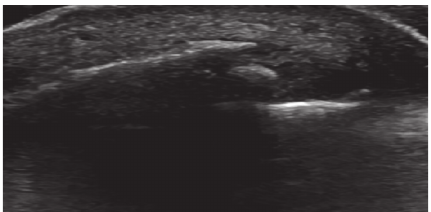
Figure 3: Axial view ultrasound evaluation in a patient with subacute symptoms also shows a large enthesophyte at the insertion of the Achilles